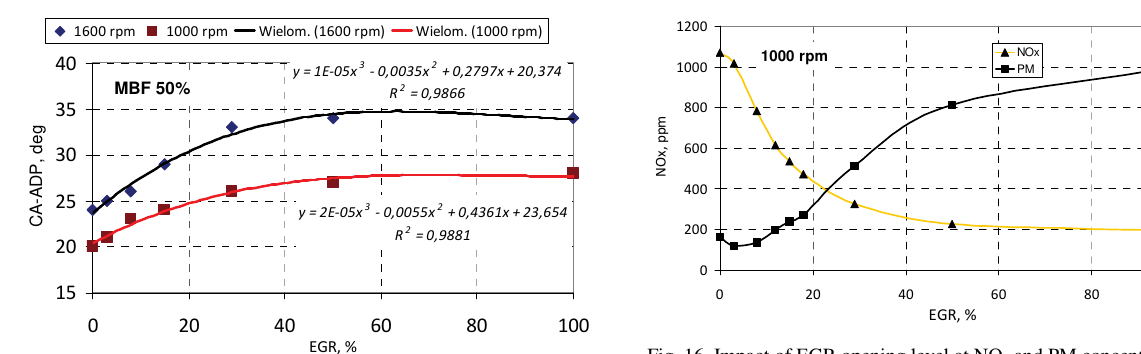
Fig. 16. Impact of EGR opening level at NO x and PM concentration (1000 rpm, 190 Nm)